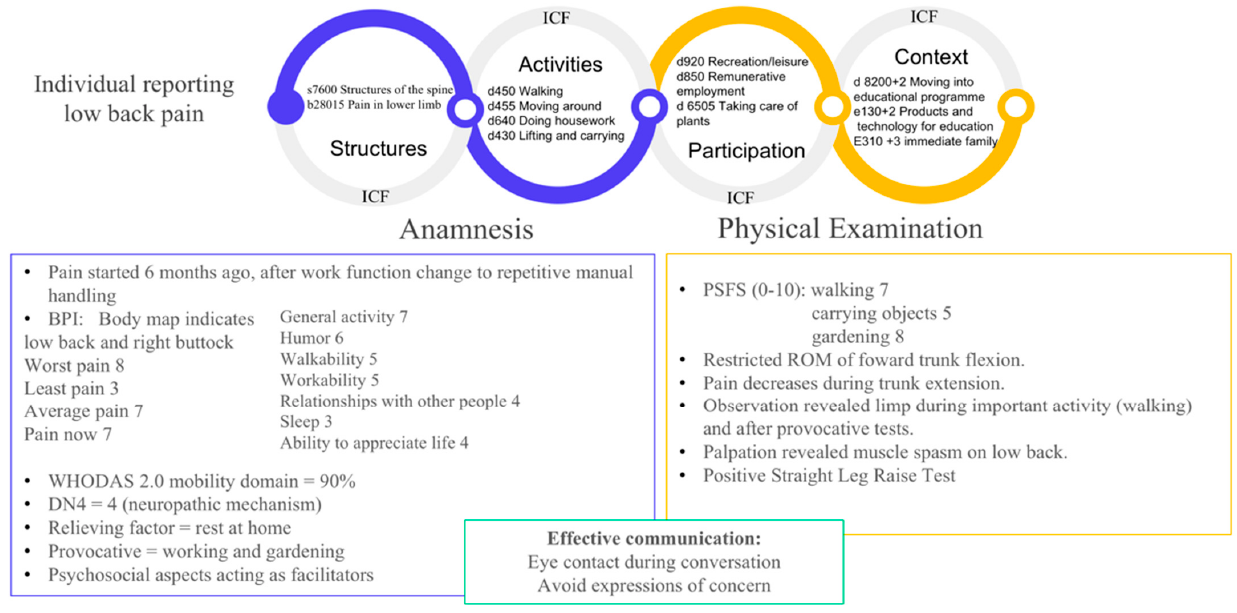
Figure 5. An example of clinical application of the chronic musculoskeletal pain framework.